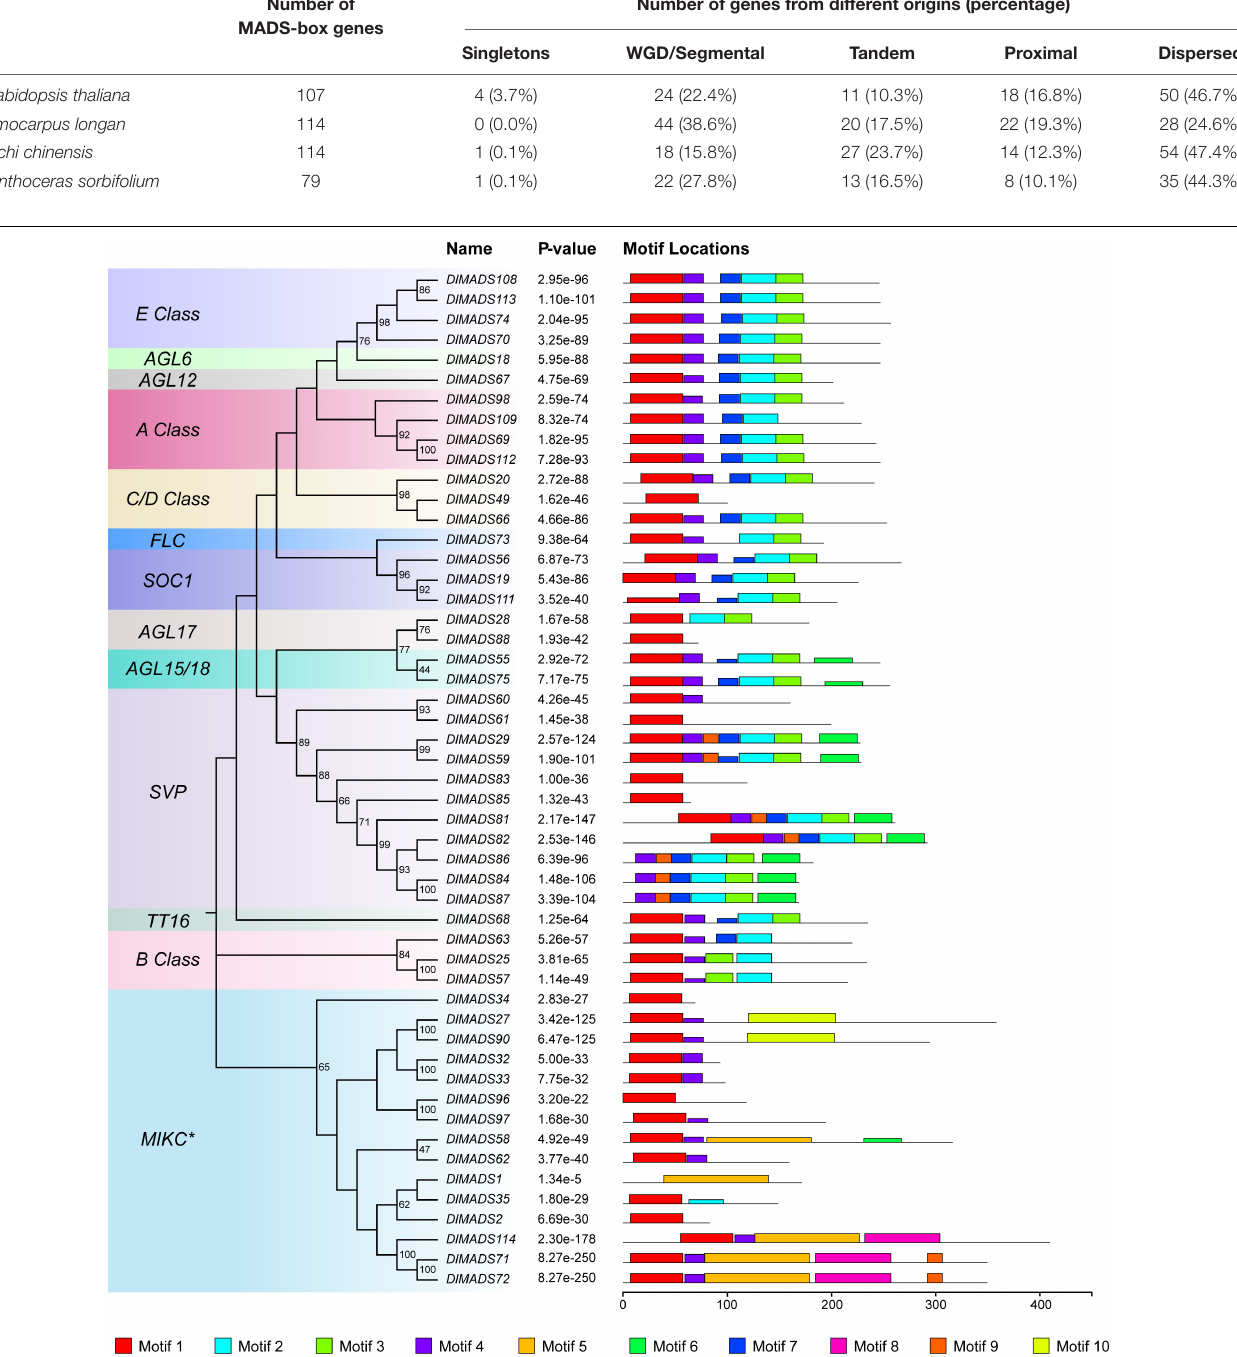
TABLE 1 | Numbers of MADS-box genes from different origins in Arabidopsis, longan, litchi, and yellowhorn genomes.